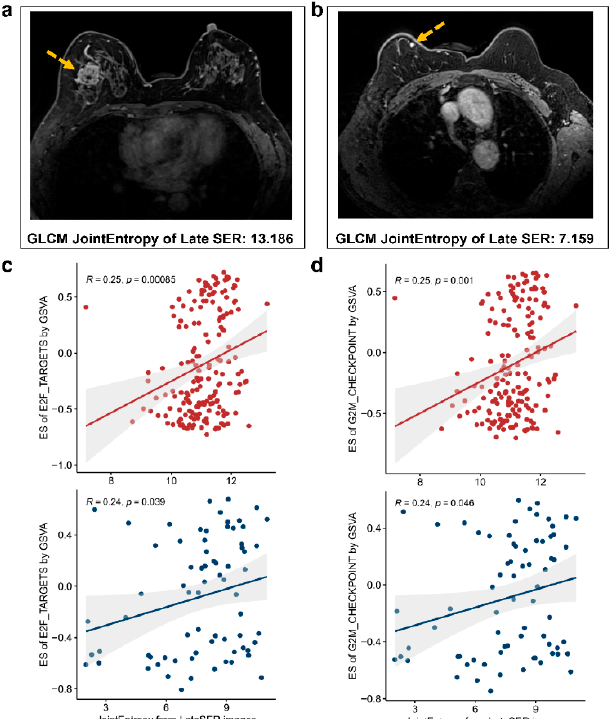
Figure 4. Quantitative associations of GSVA enrichment scores of two cell cycle-related hallmark pathways with imaging features. The significant Pearson correlation coefficients of the enrichment scores of both “E2F TARGETS” and “G2M CHECKPOINT” pathways with the imaging features for the discovery and validation cohorts are detailed in ( a ) and ( b ), respectively. Non-zero values in the cells represent significant correlation coefficients, and zero represents non-significant correlation coefficients.